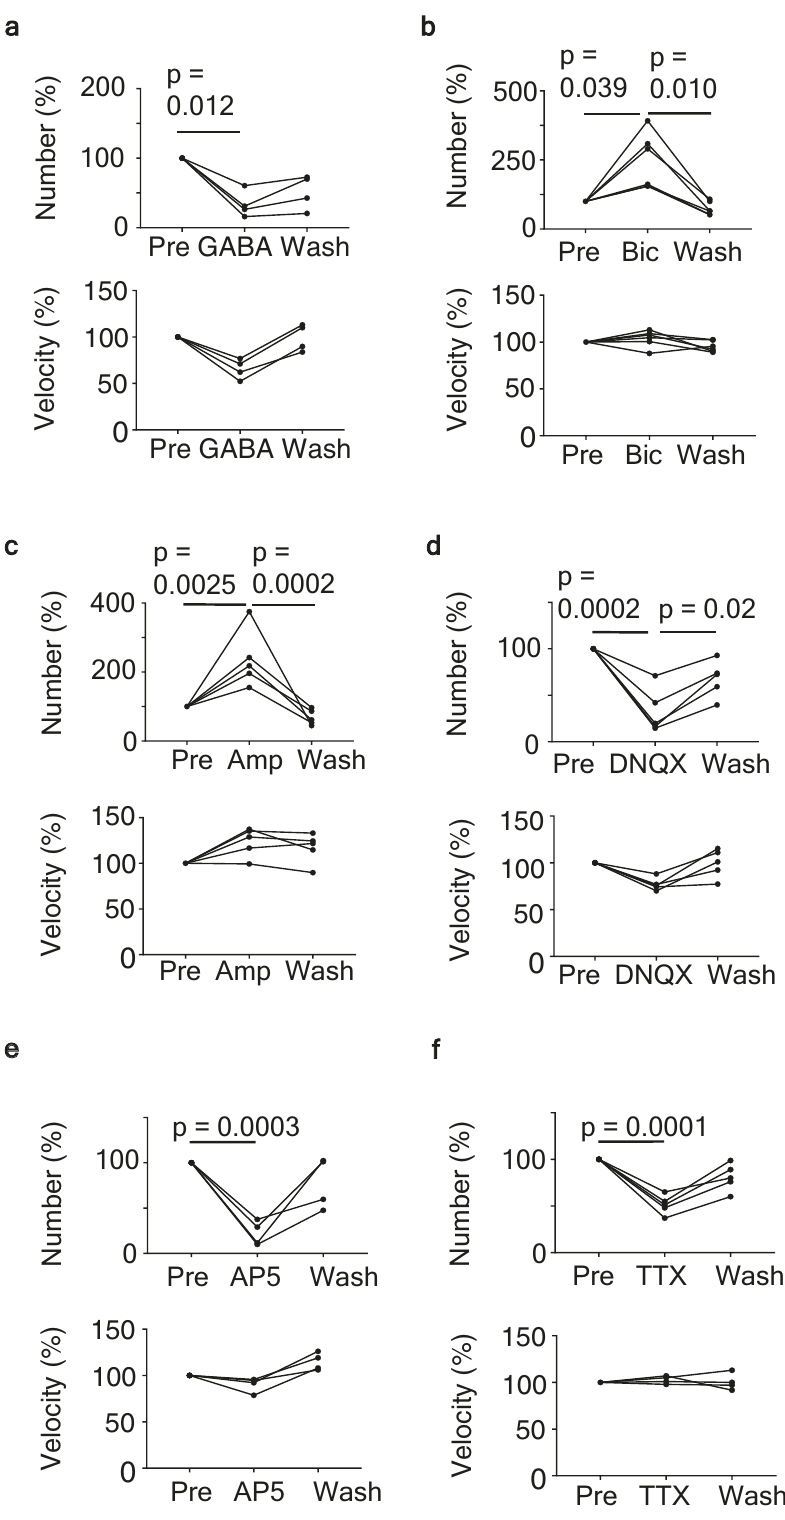
Fig. 4 QD- α -syn seed dynamics depend on neuronal activity. Effect of drugs bath-applied on QD- α -syn seed dynamics in the slice. a GABA, b bicuculline (GABAa receptor antagonist), c ampakine (AMPA receptor agonist), d DNQX(AMPA receptor antagonist), e AP5 (NMDA receptor antagonist), and f TTX, tetrodotoxin. Top panels: number of QD- α -syn seeds normalized by pretreatment. Bottom panels: mean velocity of QD- α -syn seeds normalized by that of pretreatment. Experimental procedure and ROI are the same as in Fig. 3a. n = 4 – 6 mice. p < 0.05: statistically signi fi cant by one-way ANOVA followed by Tukey ’ s post